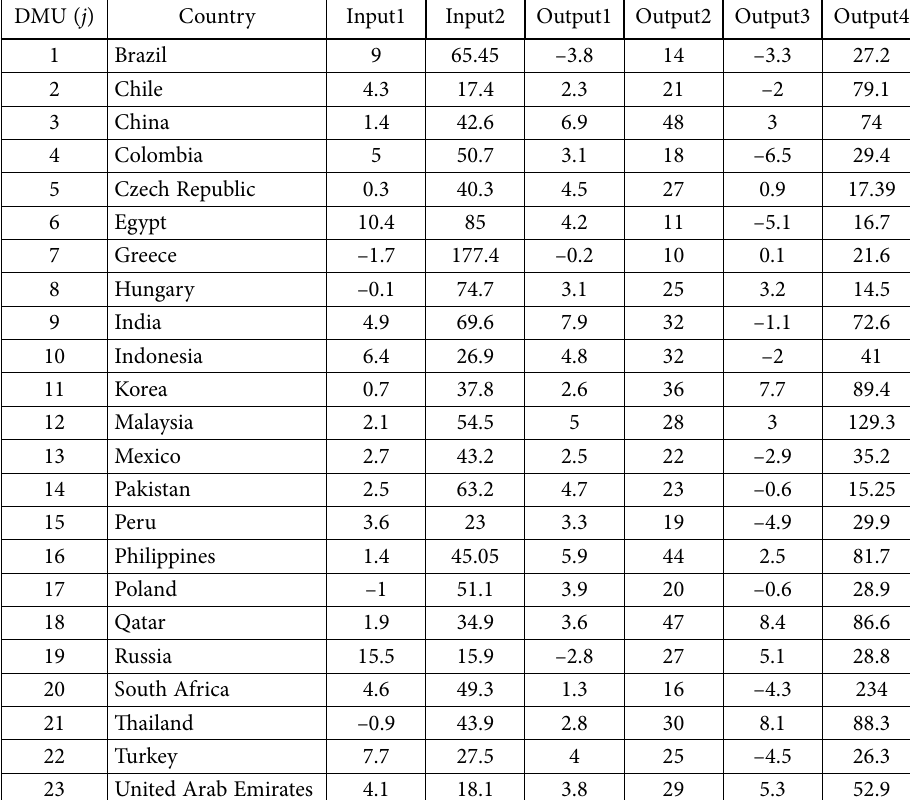
Table 3. Input and output data for MSCI Markets (source: Trading Economics, n.d.; World Bank,